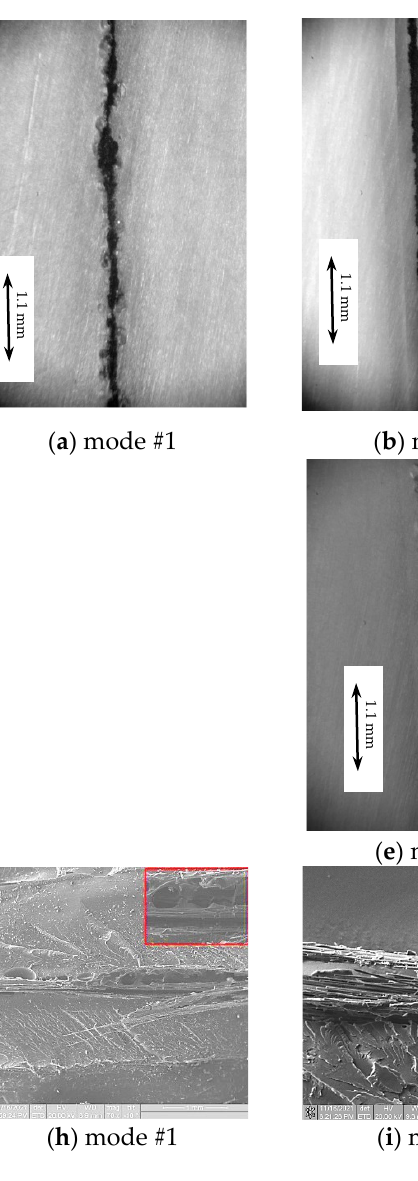
Figure 8. Macrostructure of the test coupons’ cross sections at the central part of the USW joints formed using the modes according to Table 1 ( a – g ) and micrographs of their fusion zones ( h – k ).